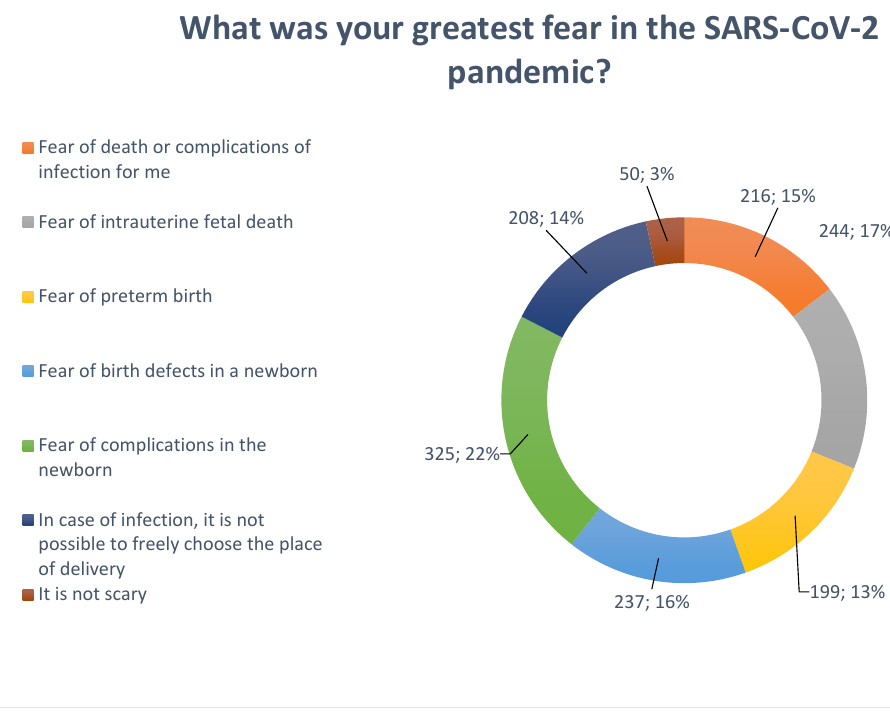
Figure 3. Factors that cause anxiety in pregnant women about the risk of COVID-19 infection. The impact of the pandemic on pregnancy check-ups was also analyzed. The hardest part for pregnant women was the absence of their partner during the visits. (Figure 4)